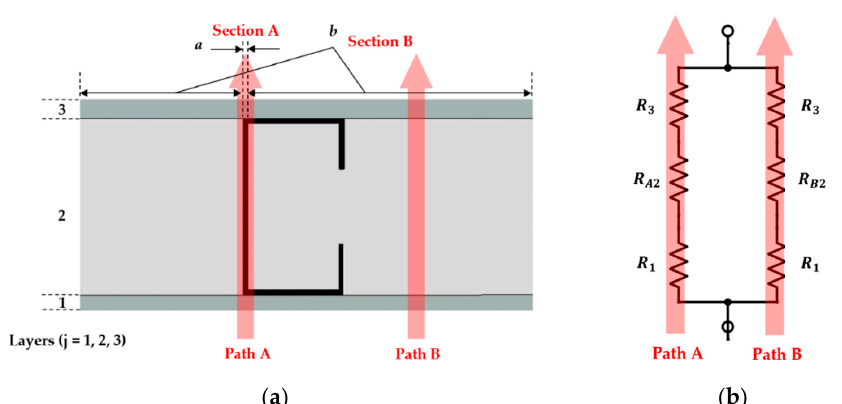
Figure 5. ( a ) Cross-section of the CFS framed wall with two main paths; ( b ) Equivalent circuit using the parallel path method. The upper limit is given by,